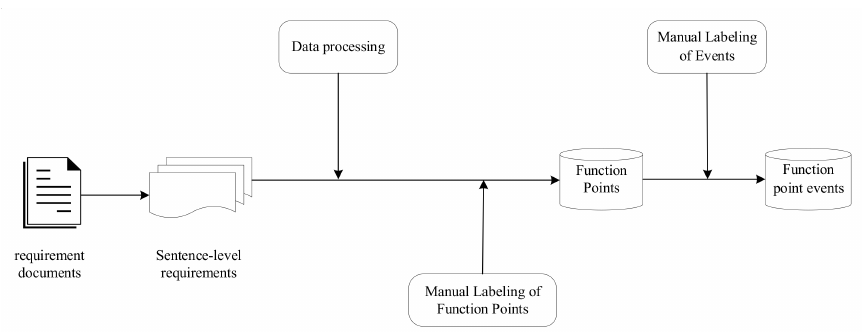
Figure 2. Flowchart of dataset